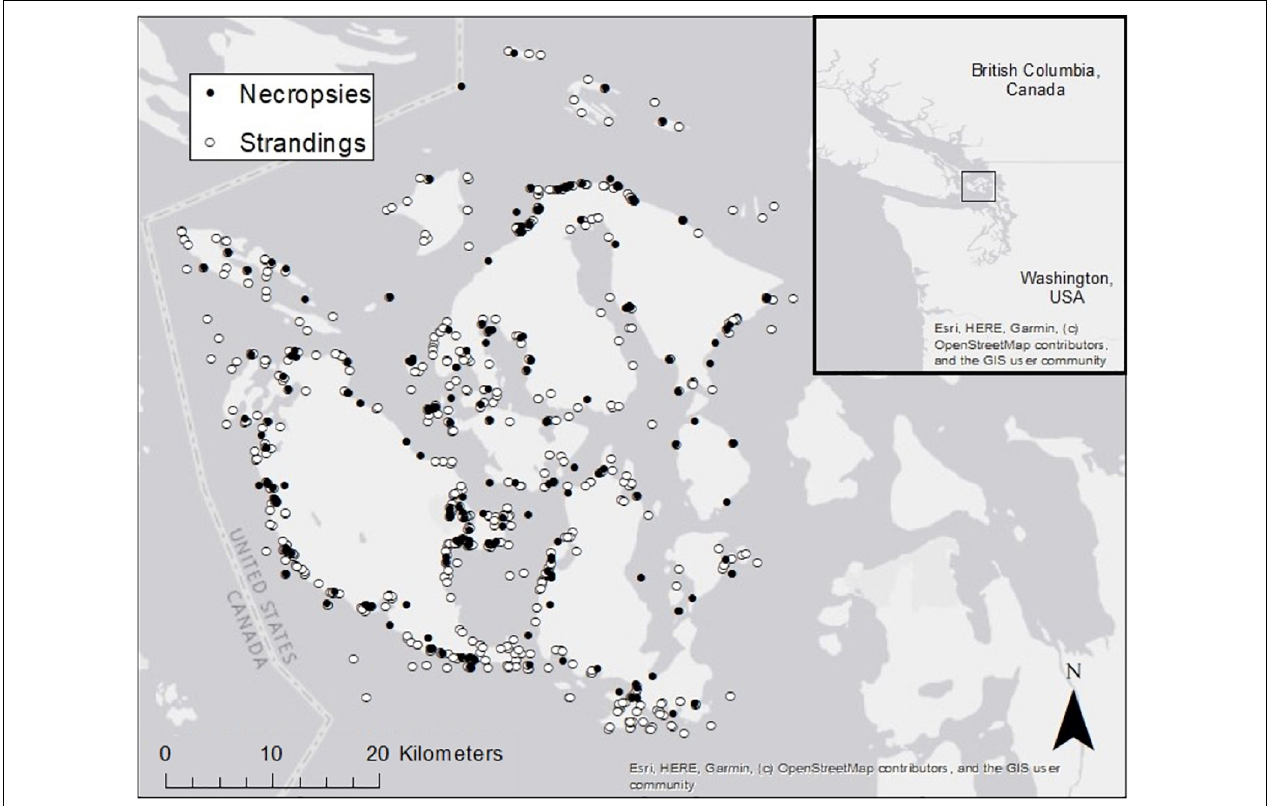
FIGURE 3 | Known stranding locations of dead harbor seals that were necropsied (closed circles, 85% represented) or were not necropsied (open circles, 79% represented) in San Juan County between 2002 and 2018.